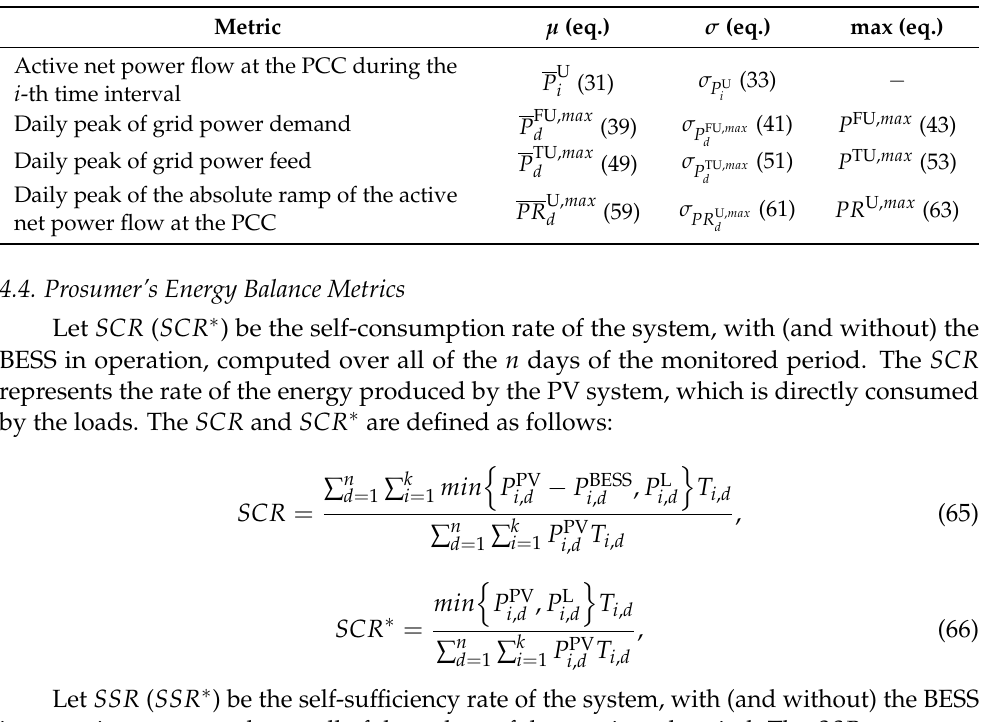
Table 5. Summary of the metrics and reference to the related equations adopted to analyze the net power profiles at the PCC with the utility for Scenario C, i.e., with PV and storage. µ : average value, σ : standard deviation, max: maximum